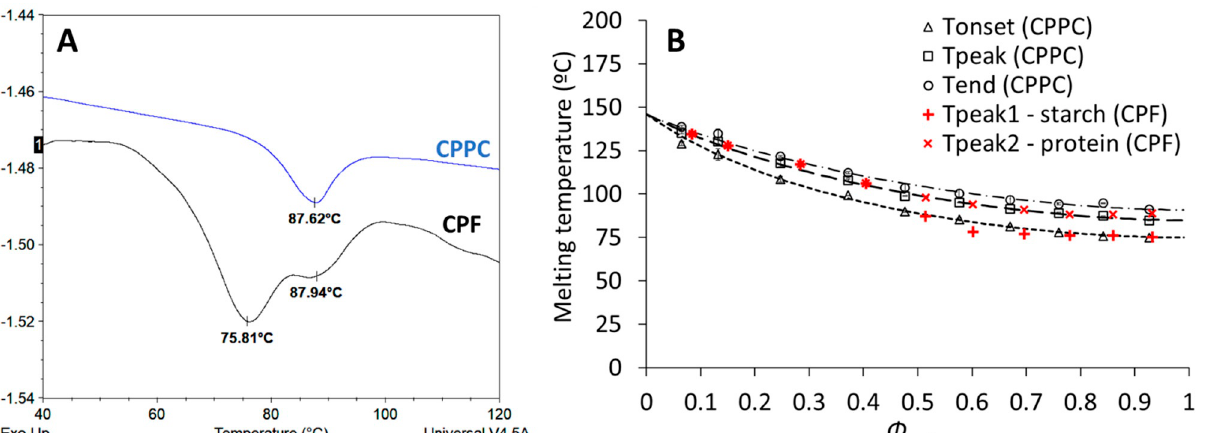
Figure 1. SDS-PAGE of CPF (2) and CPPC (3) with molecular weight markers (1). Proteins were stained with Coomassie blue.